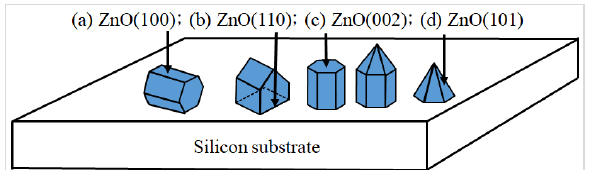
Figure 2: Microstructure and crystal growth orientation of ZnO grown on silicon substrates. (a) ZnO(100) on the Si(111) substrate, a polygon structure with the c -axis growth parallel to the substrate; (b) ZnO(110) on the Si(100) substrate, a ZnO grain with a ridge-like structure; (c) ZnO(002) on the Si(111) substrate, a ZnO grain with a pyramid-like structure (hexagonal cylinder with or without a pyramidal tip); (d) ZnO(101) on the textured Si substrate, a ZnO grain with the pyra- midal tip without a hexagonal cylinder.